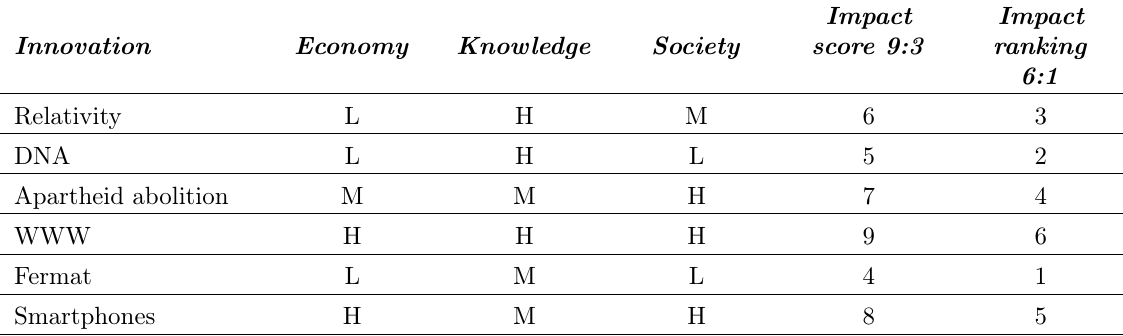
Table 2. The six innovation cases are ranked with respect to their overall impact (right column), and their score with respect to economy, knowledge, and society as input (H=high, M=moderate, L=low) appearing at the columns in between.